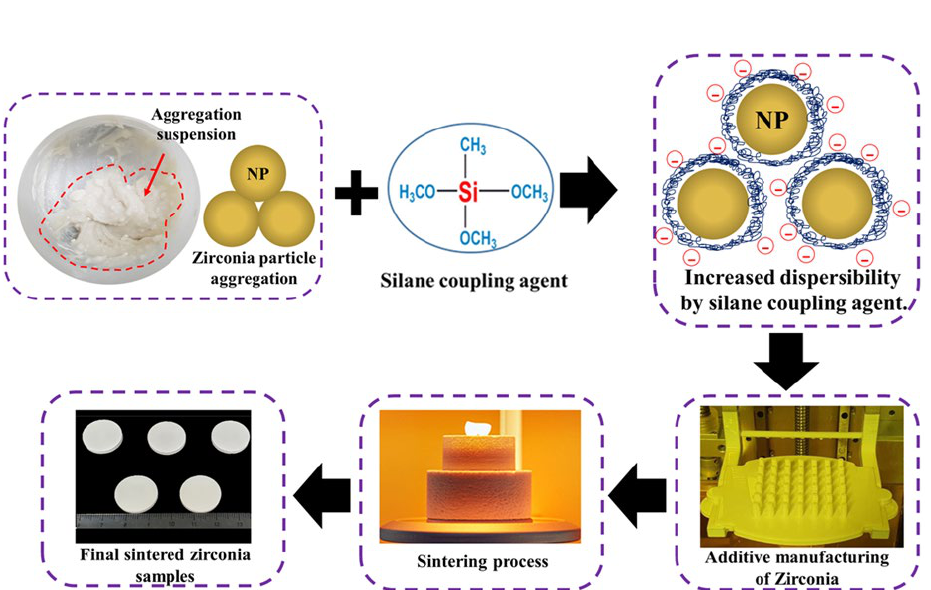
Figure 1. Schematic illustration of the experimental group process.